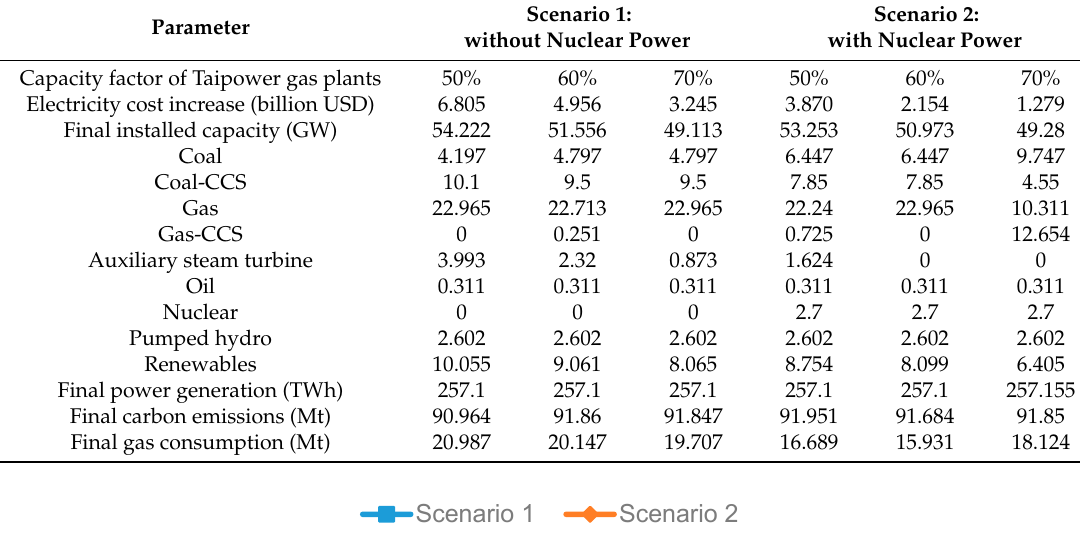
Table 7. Results summary for the case study.